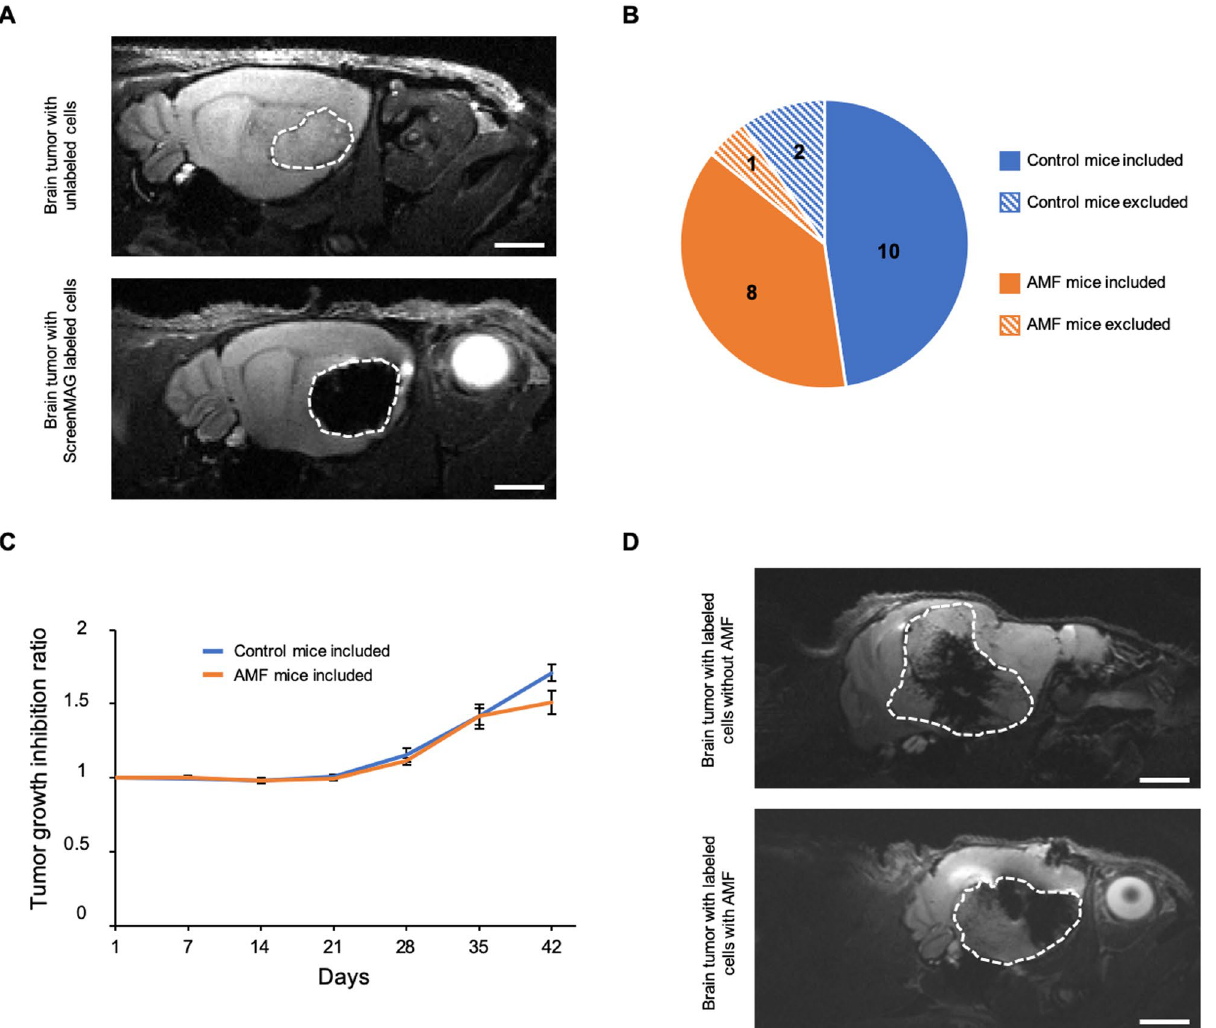
Figure 5. In vivo Magnetic fluid hyperthermia treatment. ( A ) T2-weighted MR images of mouse brains bearing intracranial tumor 7 days after the injection of unlabeled (top) or ScreenMAG-labeled (bottom) cells. White areas delimit the tumors. Scale bar: 6.5 mm. The tumor was delineated due to (1) its hypo-intense signal and (2) its hyper-intense signal compared to the surrounding healthy brain on T2-weighted images. Iron-labeled cells generate a hypo-intense signal on T2-weighted images 65 . On the other side, unlabeled tumors are depicted as hyper-intense areas in the brain on T2-weighted images 38 . ( B ) The pie diagram represents the numbers of mice included and excluded in the statistical analysis. ( C ) Tumor volume inhibition ratio of the Alternating Magnetic Field (AMF)-treated group (orange) and control group (blue) over 42 days. ( D ) T2-weighted MR images of mouse brains bearing ScreenMAG-labeled intracranial tumors, 42 days after AMF application (bottom) or not (top). White areas delimit the tumors. Scale bar: 6.5